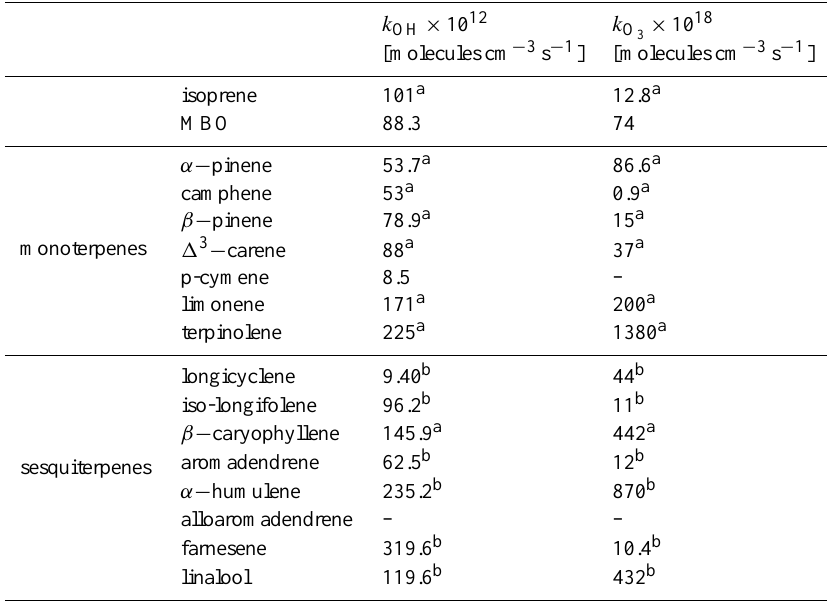
Table 1. Reaction rate constants (moleculescm − 3 s − 1 ) of the oxidation reactions of the measured VOCs due to hydroxyl radicals and